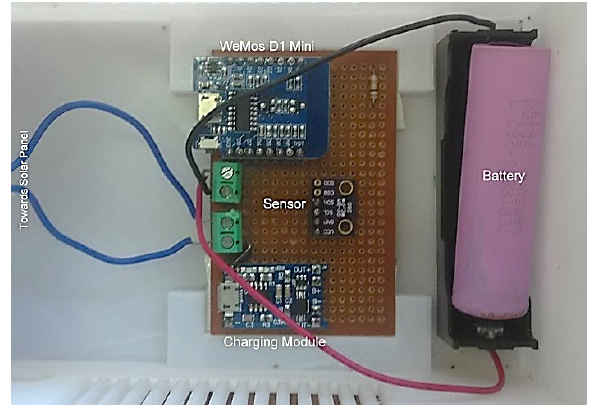
Figure.5. Implemented System